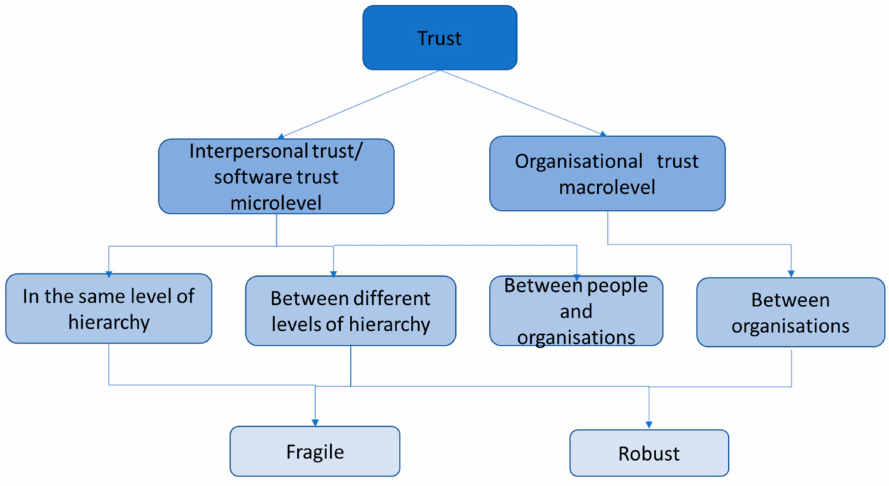
Figure 5. Schematic representation of the concept of trust